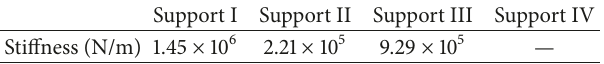
Table 2: Stiffness of elastic supports (squirrel cage).